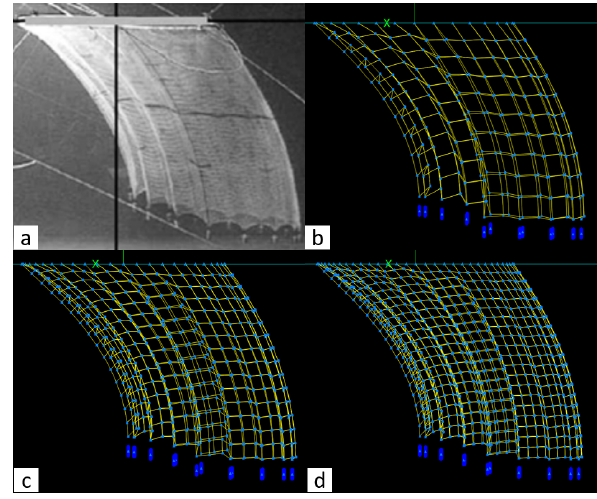
Figure 7: Cage deformation under flow speed of 0.33 m/s captured from (a) model tests Lader and Enerhaug (2005), and numerical simula- tions with different mesh configurations: (b) 32*10, (c) 48*15, (d) 64*20.